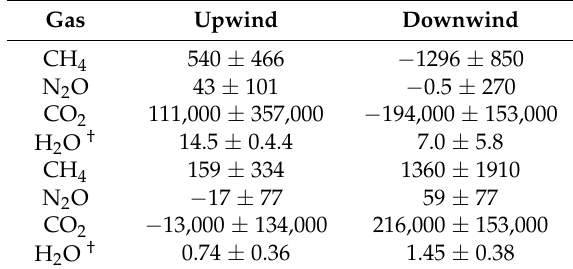
Table 1. Fluxes (g ha − 1 d − 1 ) for growing crop (upper table) and tilled stubble (lower table) where bold values are the deposition. Upwind refers to the air flow entering the feedlot and downwind refers to air flow off the